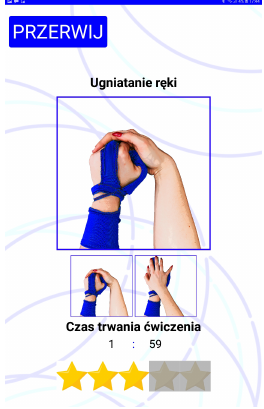
Figure 12. Main motivational aspect of Przypominajka—during the exercise, correct training is awarded with